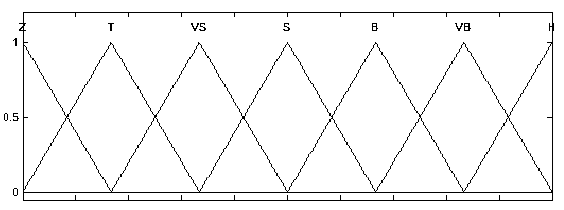
Figure 2. The membership function of FEM's output language variables